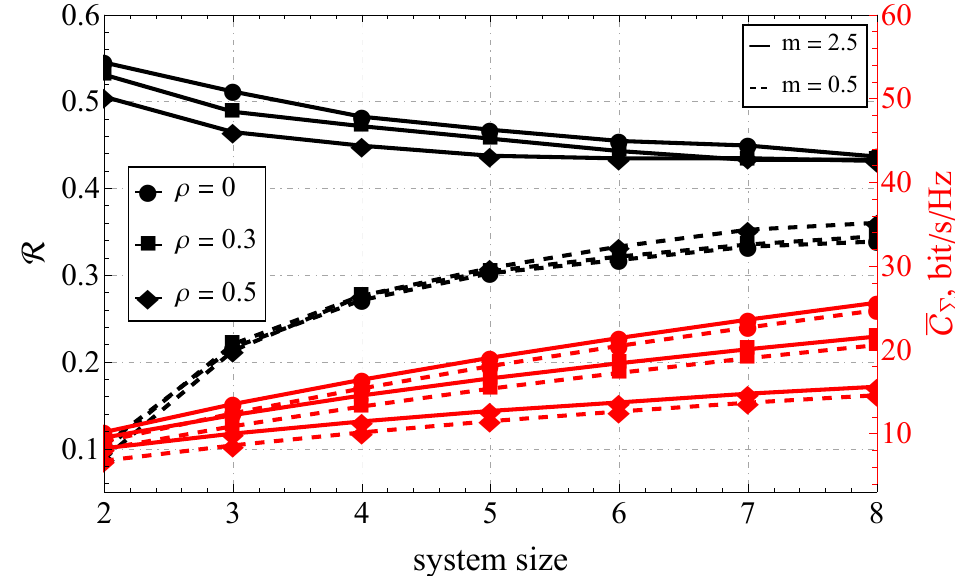
Figure 7. The joint R – C Σ performance of the variable-size MIMO system and different ρ